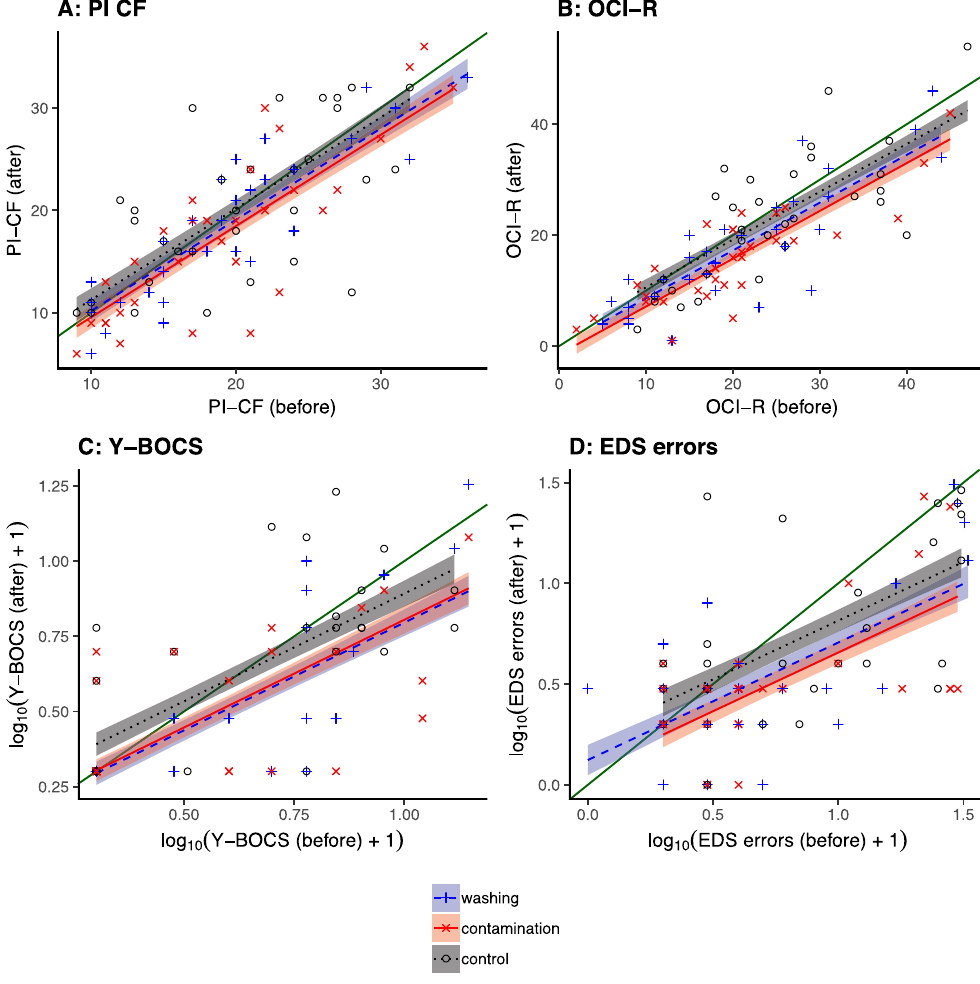
Figure 3. Scores before and after the smartphone interventions. ( A ) PI CF scores were not altered by the active interventions, compared to the control condition (see text). ( B ) OCI-R scores were reduced by both active interventions. ( C ) Y-BOCS scores were reduced by both active interventions. ( D ) EDS errors were reduced by both active interventions, compared to the control condition. Confidence ribbons indicate ± 1 standard error. The green line with no confidence ribbon is the x = y line of “no change”; deviations from this in the control condition suggest e.g. practice effects, regression to the mean, or other nonspecific